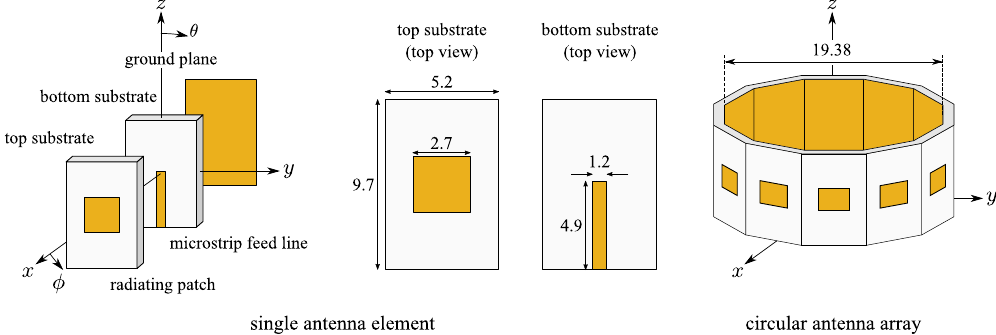
Figure 1. Structural configuration of the multilayer (double substrate) electromagnetically coupled, microstrip patch antenna element and the 12-element circular patch antenna array illustration: the dimensions of the antenna (in mm) are also depicted. Radiating rectangular patch with edge of 2.7 mm is placed in the centre of the top substrate of dimensions 5.2 mm × 9.7 mm × 0.5 mm . The bottom substrate has the same dimensions as the top, and here, the microstrip feed line with dimensions 4.9 mm × 1.2 mm is placed. The circular antenna array, which lays on the xy -plane, has diameter of 19.38 mm ( 1.8 (cid:31) ): parameters θ and φ denotes the polar and azimuthal